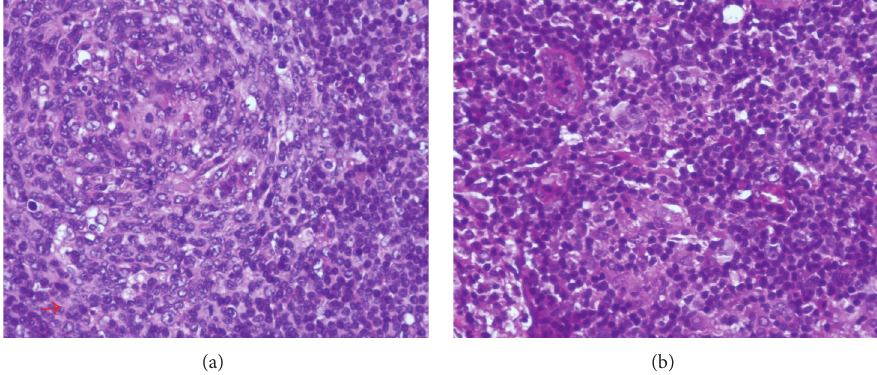
Figure 2: Microscopic findings of lymph node biopsy revealing (a) a preserved lymph node architecture with multiple lymphoid follicles, with or without hyalinized arteriolar (HESx40) and (b) typical Reed-Sternberg cells in the interfollicular.